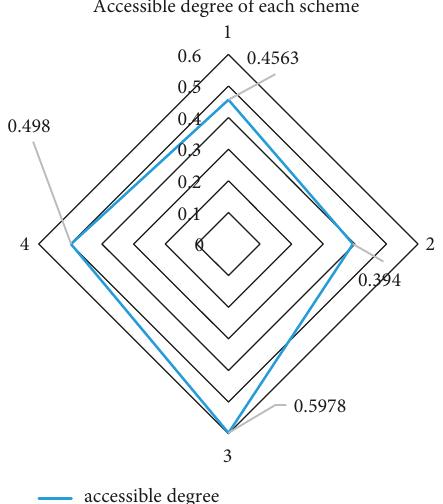
Figure 3: Accessible degree of each